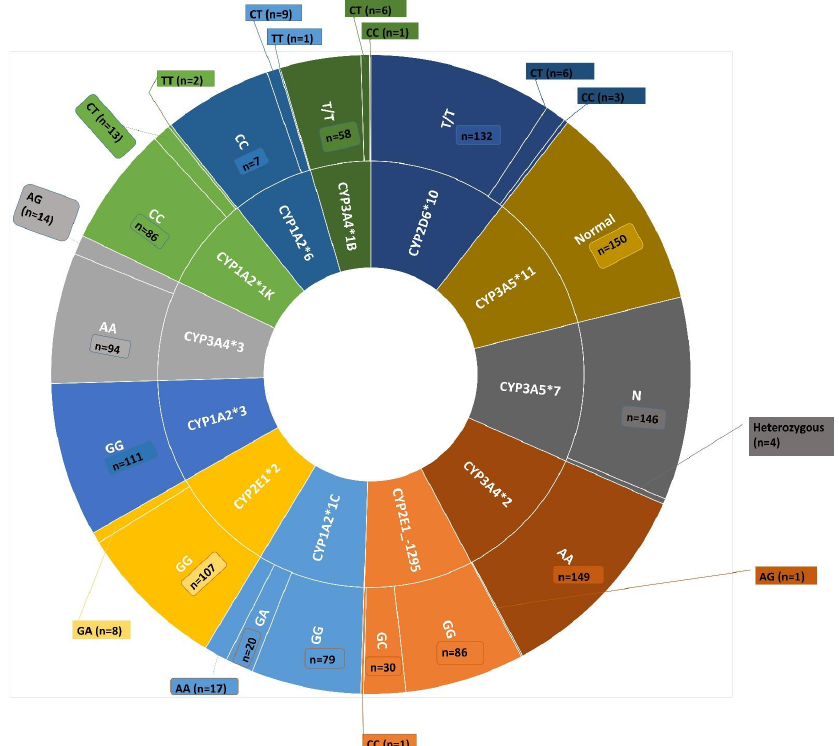
Figure 1. Prevalence of SNPs amongst the study participants. The inner circles represent the CYP enzymes evaluated in this study. The specific SNPs for each of the CYP enzymes are mentioned in the outer circles including the number of patients observed with each polymorphism.